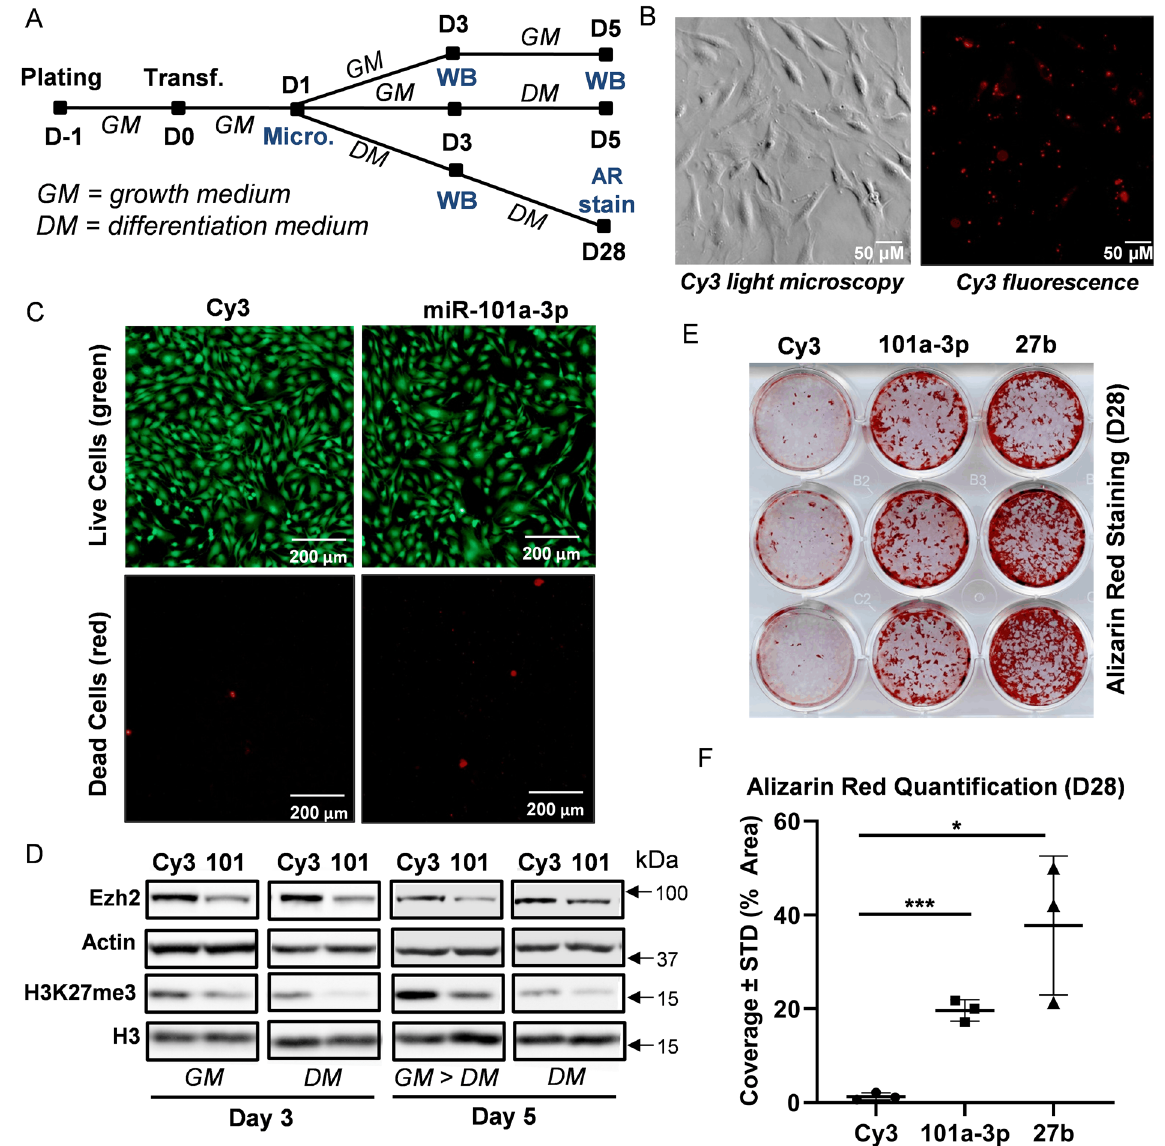
Figure 2. miR-101 targets Ezh2 and stimulates mineral deposition in differentiating MC3T3 cells. Experimental set-up of MC3T3 transfection and differentiation ( A ). Cells were plated and transfected in growth medium. Cells were then maintained in growth medium (GM) and differentiation medium (DM) for indicated times. Media were changed every two to three days ( Micro. Microscopy, WB Western blotting, AR stain alizarin red staining). Representative light and fluorescence microscopy images of Cy3 dye-labeled pre-miRNA negative control transfected MC3T3 cells one day after transfection ( B ). Representative live (green) and dead (red) fluorescence microscopy images of Cy3 negative control and miR-101a-3p transfected MC3T3 cells ( C ). Western blot analysis of MC3T3 cell lysates transfected with Cy3 negative control and miR-101-3p ( D ). Alizarin red staining ( E ) and quantification ( F ) of differentiating MC3T3 cells (day 28) transfected with CY3 control, miR-101a-3p, and miR-27b [n = 3, mean ± standard deviation (STD)]. *p < 0.05 and ***p < 0.001. All experiments were repeated at least three (Fig. 3). In a RT-qPCR screen of eight tissues, GFP expression is evident in skin, spleen, and bone (femora) in eight-week-old female mice on doxycycline diet (Fig. 3A). Because GFP is not normally expressed in mice, the GFP/miR-101a transgene model should represent a zero-background system in the absence of doxycycline. Nevertheless, we detected low levels of GFP expression due to ‘leaky’ transcription from the TRE-tight promoter in tissues from mice maintained on a regular diet see (black bars in bone). Similar to GFP, mir-101a expression is enhanced by doxycycline administration in skin, spleen, and bone (Fig. 3B). Unlike GFP, miR-101a is also up-regulated in liver; because the transgene transcript encodes both RNAs, this finding may perhaps reflect the relative stabilities of small miRNAs versus longer mRNAs.